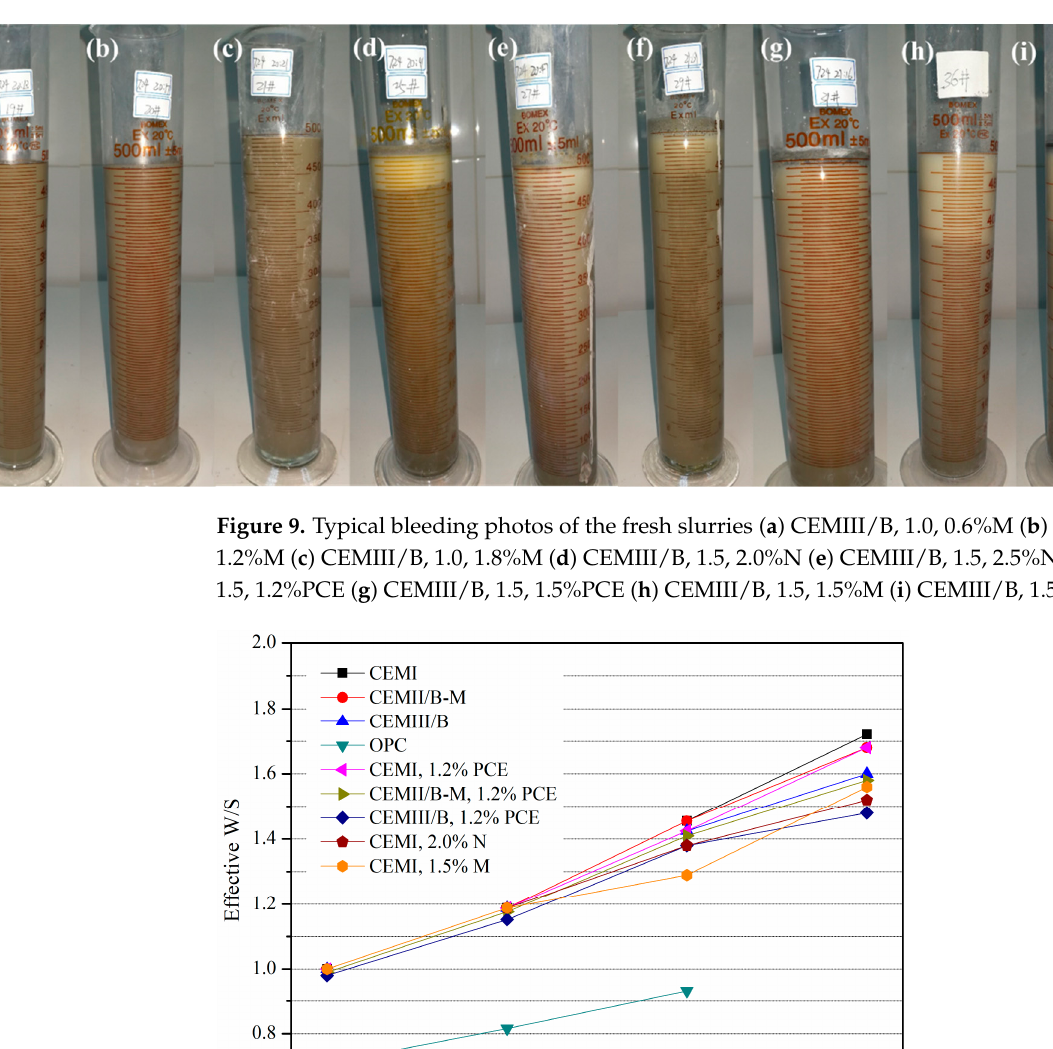
Figure 8. Effect of SP content and cement type on bleeding rates of fresh SMCG at W/S of 1.0 and 1.5.